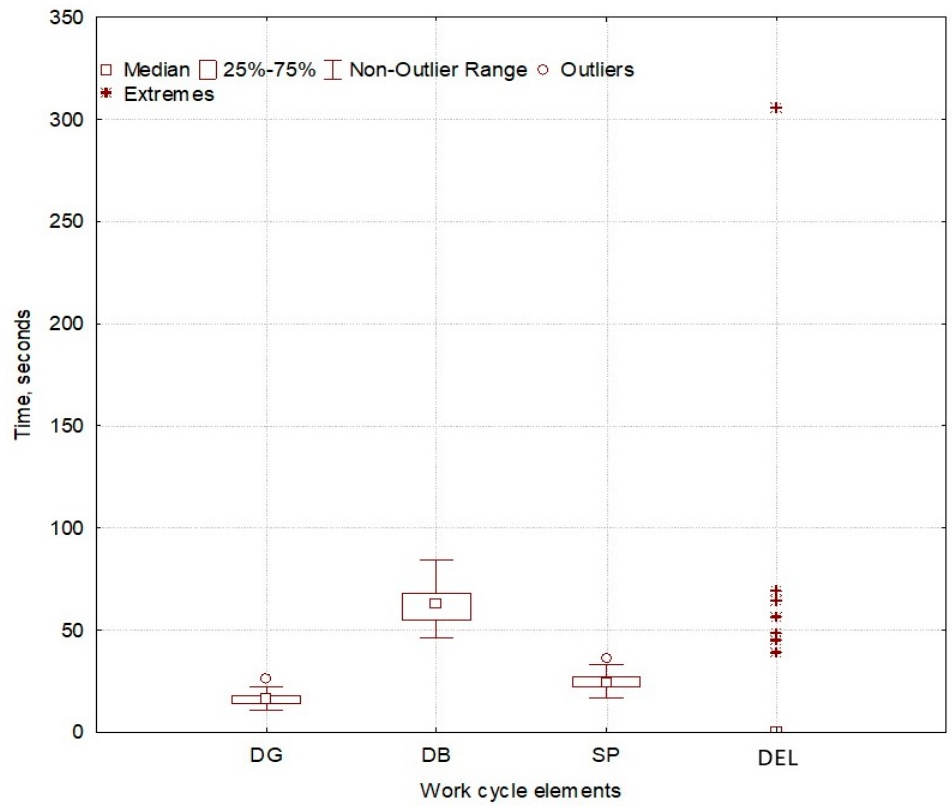
Figure 4. Elemental time consumption of processor